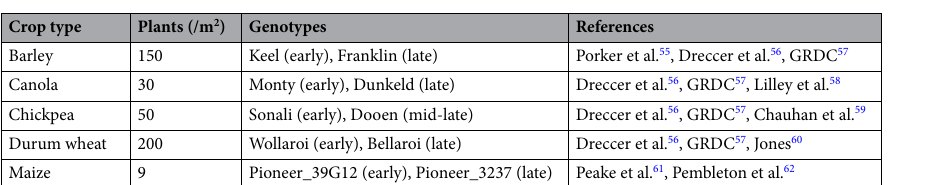
Figure 2. Historical and future climates across four environments in Australian irrigated cropping zones. Averaged across regions, monthly rainfall under future climates (red bars) was reduced by 14% relative to historical rainfall (blue bars); monthly maximum temperature of future climates (red triangles) and monthly minimum temperatures (red squares) were on average 15% greater than corresponding historical daily temperatures (blue points).